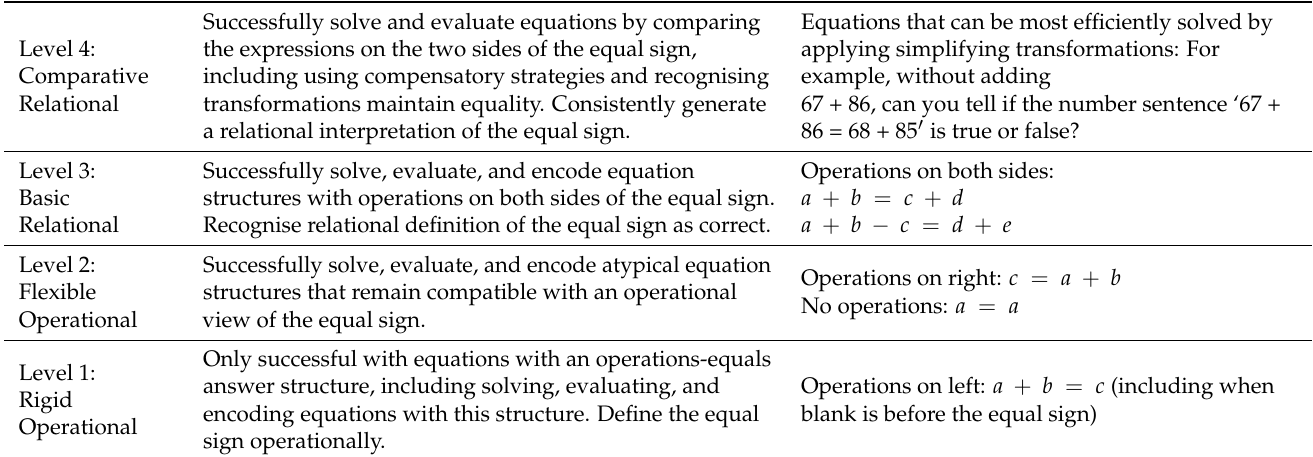
Table 1. ‘Construct map for knowledge of the equals sign as an indicator of mathematical equality.’ (adapted from [27] (p. 224)).